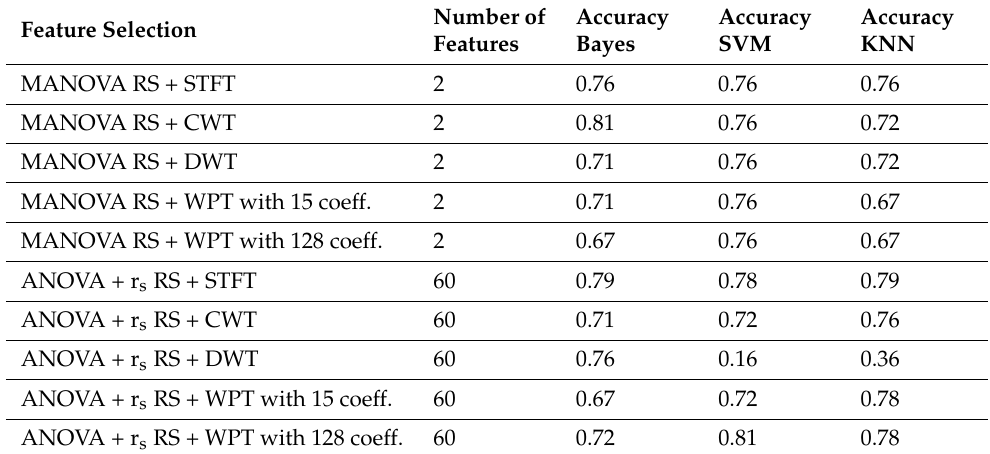
Table 8. Evaluations of the classification models for the classification of the profile total deviation.